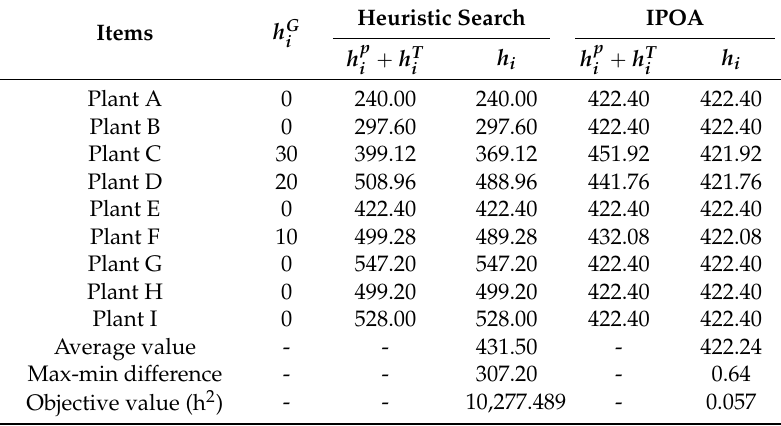
Table 4. Comparison of capacity utilization hours of each plant